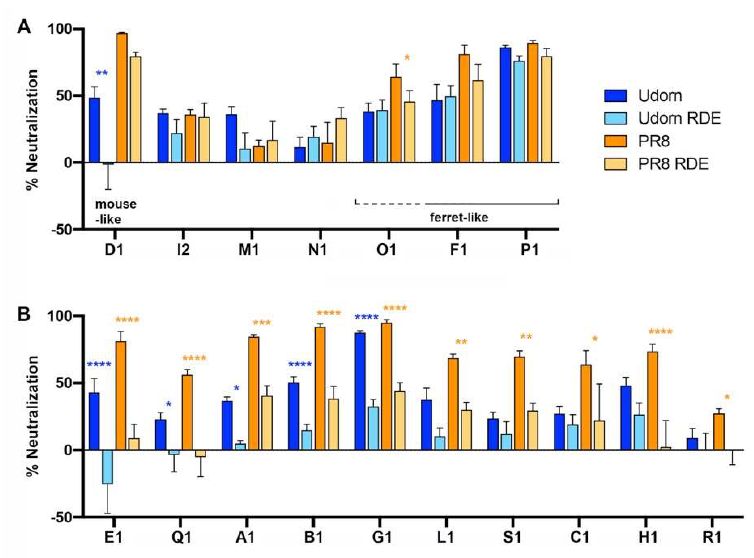
Figure 3. Inhibition of IAV by individual infant saliva samples. PR8 or Udorn virus (5000 PFU) were added to untreated or RDE-treated human infant saliva as described for Figure 2. The data represent the percentages of virus neutralized by saliva compared to control mixtures containing 5000 PFU of virus and RPMI + BSA. The means and standard deviations of at least three replicate samples are shown and represent data obtained from 17 individual human infants.